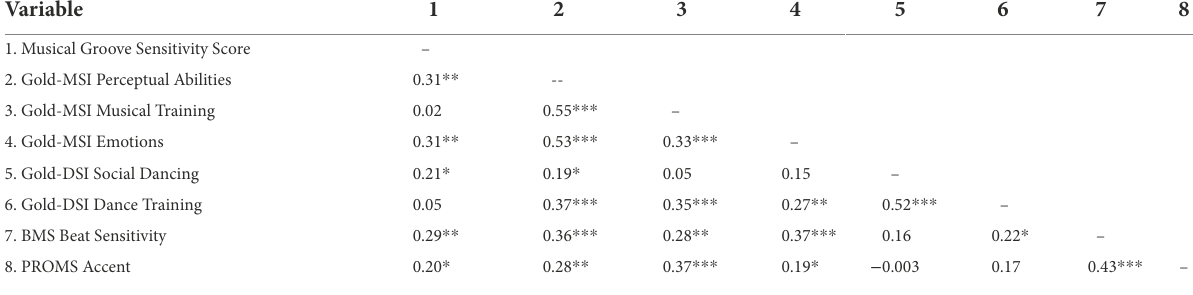
TABLE 5 Correlations between variables in stepwise multiple linear regression analysis.